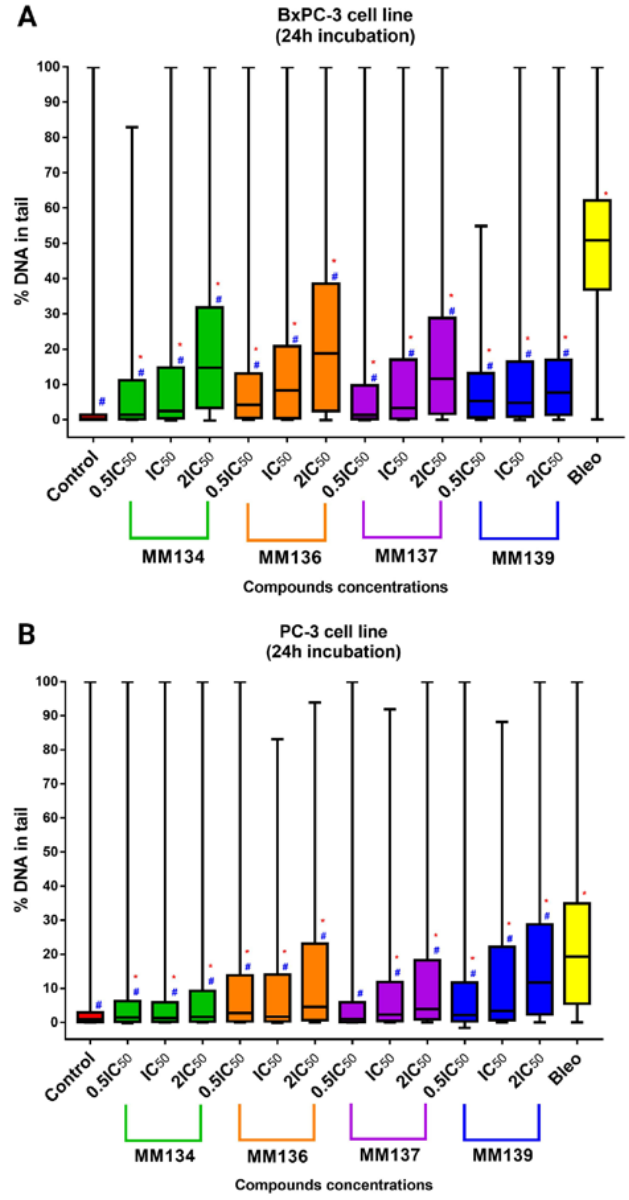
Figure 5. DNA damage in cancer cells estimated with 24 h alkaline comet assay: determination of DNA damage induced by 0.5 × IC 50 , IC 50 , and 2 × IC 50 concentrations of MM134 , -6 , -7 , and -9 in cancer cell lines (BxPC-3 ( A ), PC-3 ( B )). Data are represented as median tail DNA % with interquartile range and minimal and maximal values. The Kruskal–Wallis test was used to show a statistically significant difference between groups. Multiple comparisons using mean ranks for all groups module of Statistica software were used. In all groups, N > 200. * significant difference compared to the negative control; p < 0.05. # significant difference compared to the positive control (20 µ M bleomycin); p <